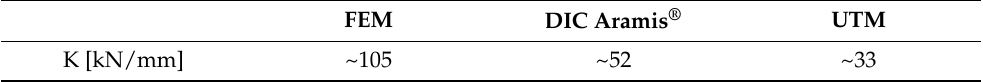
Table 6. Stiffnesses of the profile (K) determined for the case without temperature